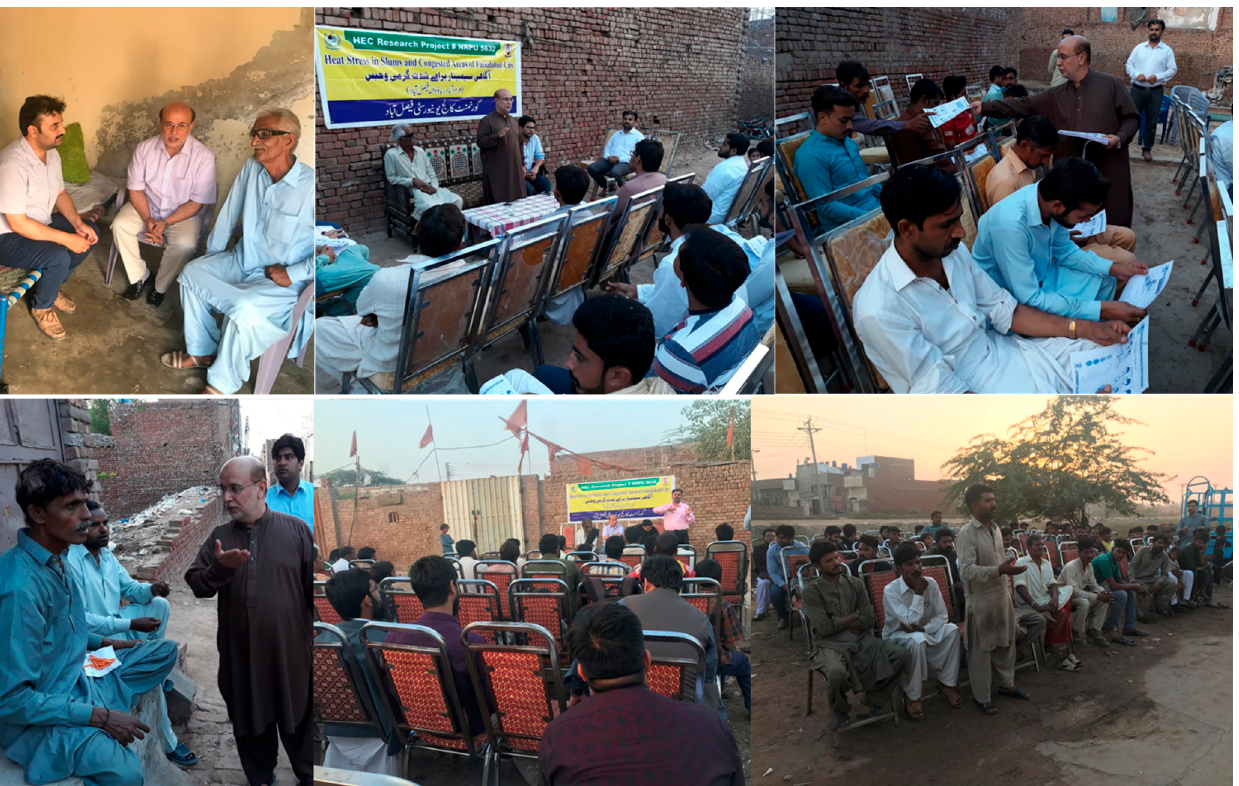
Figure 1. Meeting of some members of study team with community heads to convince them for attending community awareness seminars in Babuwala and Muradabad sites of this study about the importance of the talk and their participation in the study activities.